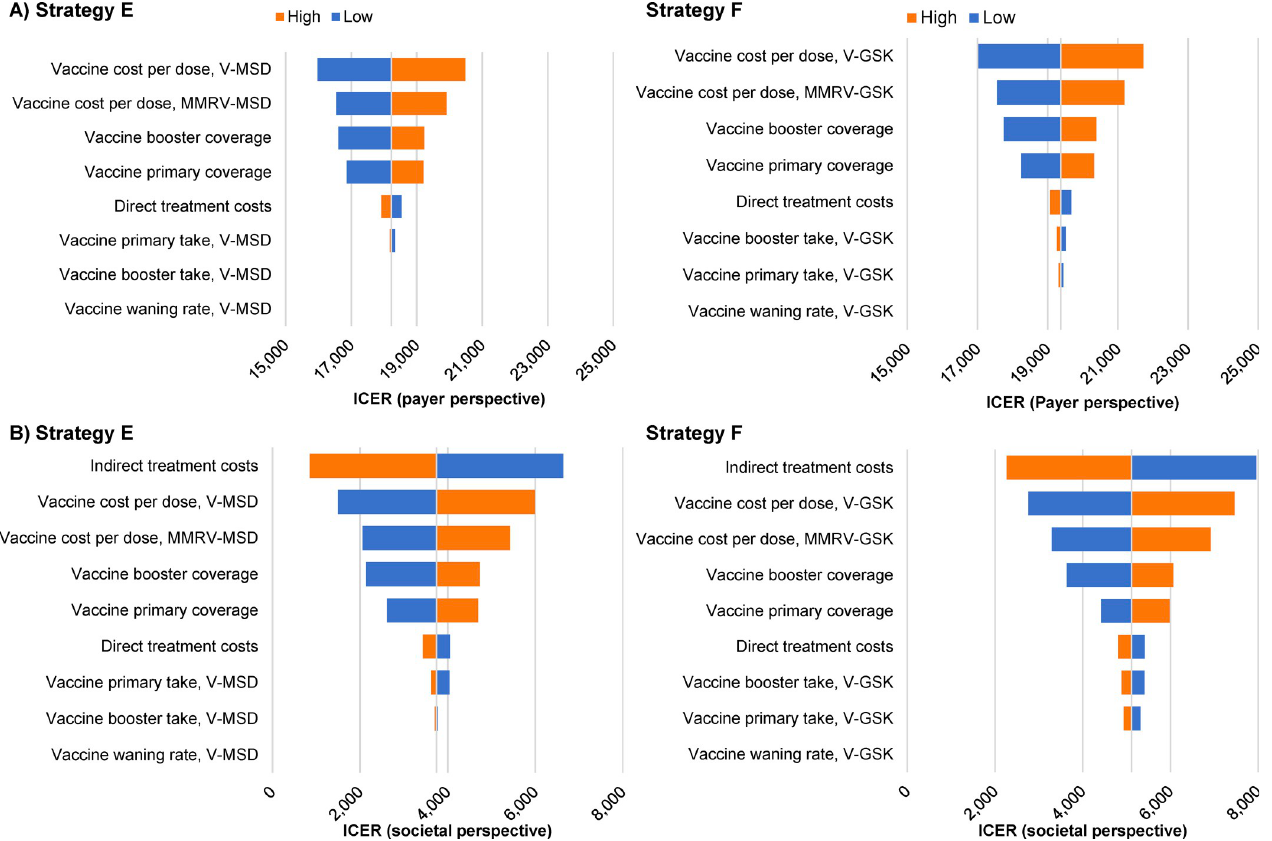
Fig 4. One-way sensitivity analysis on incremental cost-effectiveness ratio for vaccination Strategy E and F, from the A) payer and B) societal perspectives. Blue and orange bars show the ICER under the lower and upper parameter value assumptions, respectively. Strategy E : V-MSD (15 months) + MMRV-MSD (48 months). Strategy F: V-GSK (15 months) + MMRV-GSK (48